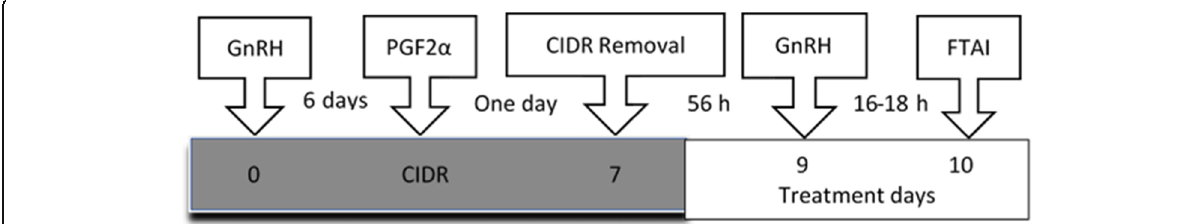
Fig. 3 Schematic representation of the CIDR-Ovsynch breeding program. CIDR, controlled internal drug release; (PGF2 α , prostaglandin F2 alpha; GnRH, gonadotropin releasing hormone; FTAI, fixed-time artificial